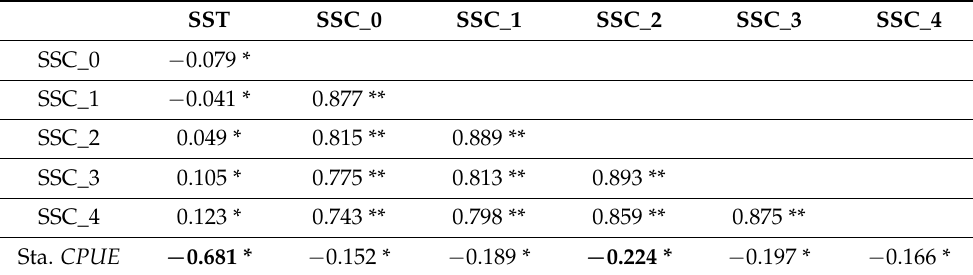
Table 2. Correlation analysis between different environments and between environmental variables and standardized CPUE . Bold values were selected for the final model.